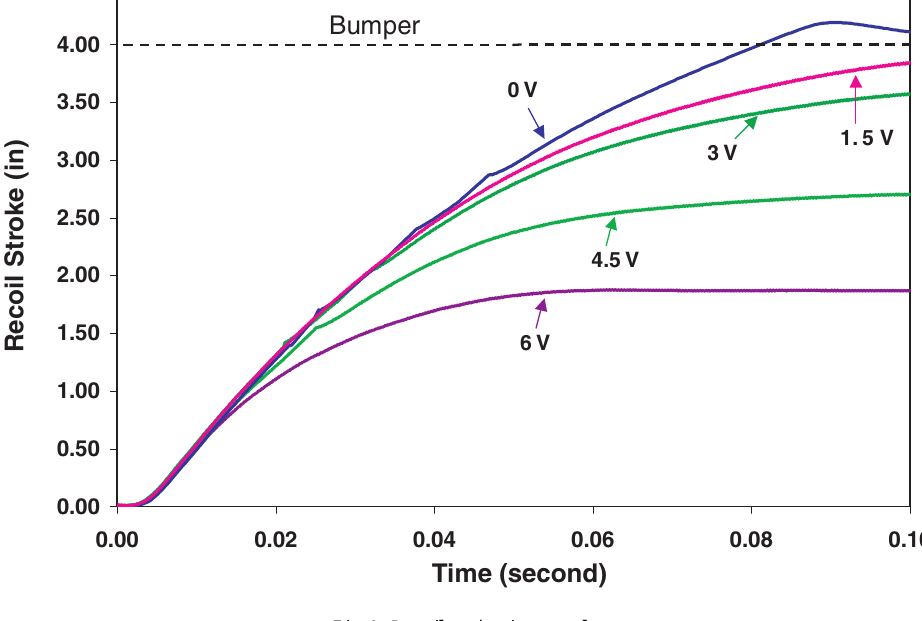
Fig. 9. Recoil stroke time profile.